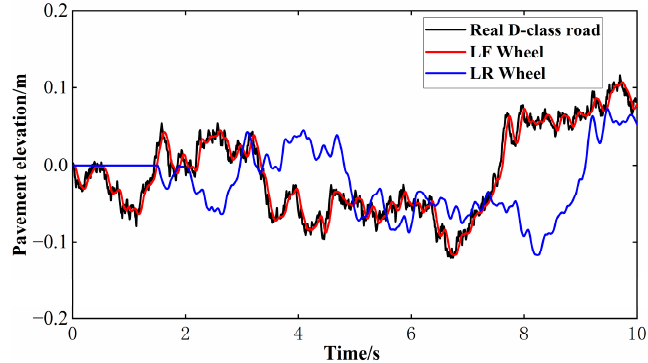
Figure 6. D-class road disturbances on left front and rear wheels.